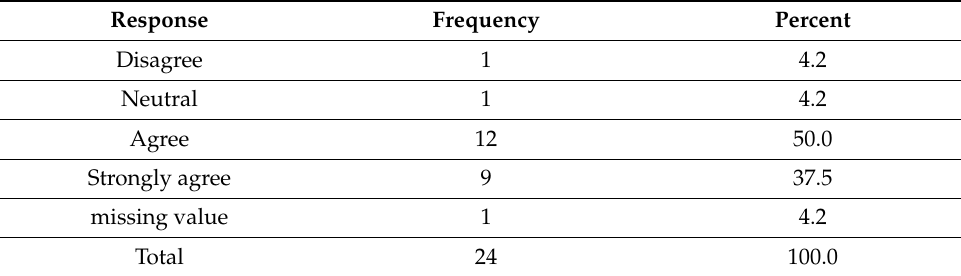
Table 2. Perception of Women on the Acceptability of Questioning about DVA by Dentists.